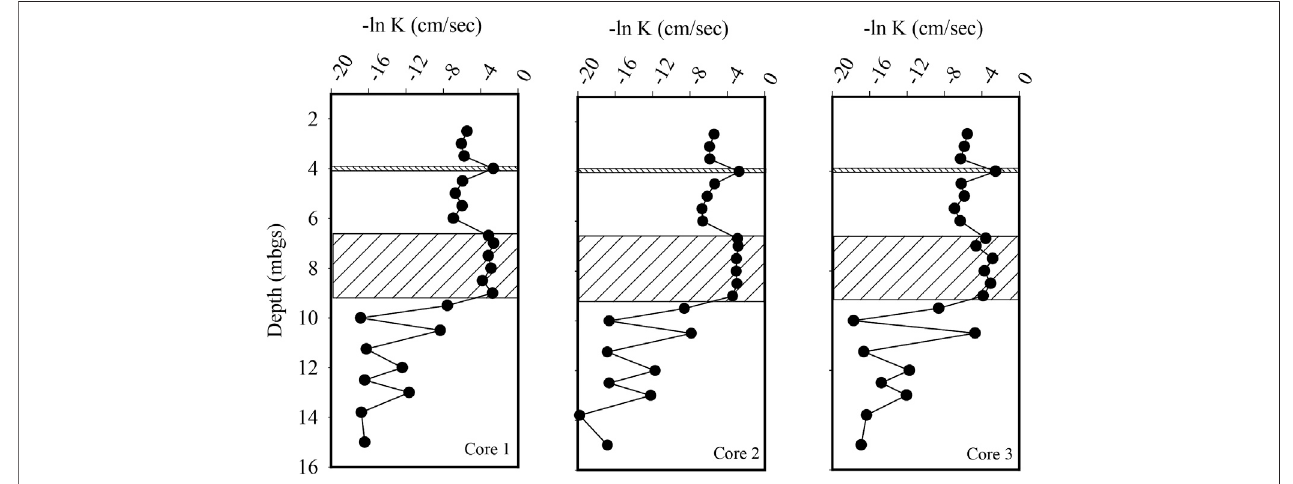
FIGURE2| Horizontalhydraulicconductivity(K H )pro fi leswithinthethree-aquifersystem.Thehatchedarearepresentssandaquiferwhichisoverlainbyasiltysand till and underlain by a fractured dolostone.